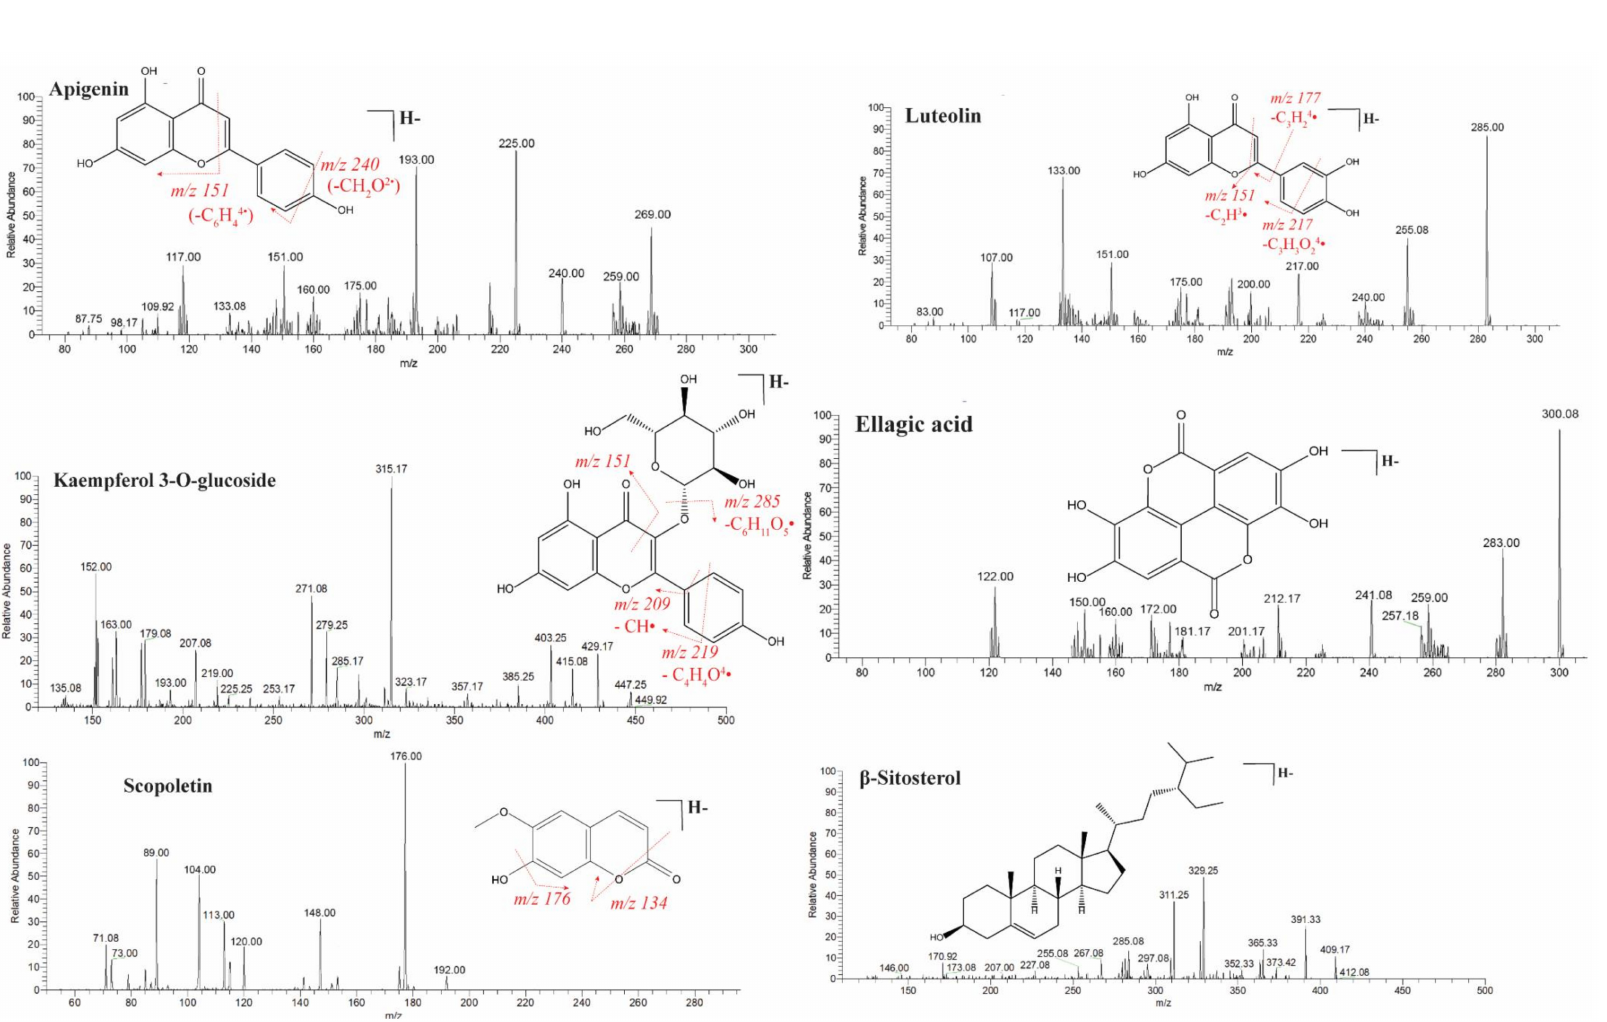
Figure 1. ESI-MS/MS spectra in negative and positive mode for tentative compounds of a hydroethanolic extract of C. sativus seeds. The tentative compounds are quercetin, kaempferol, stigmasterol, epicatechin, ferulic acid, 1,4-dicaffeoylquinic acid, apigenin, luteolin, kaempferol-3- O -glucoside, ellagic acid, scopoletin, and β